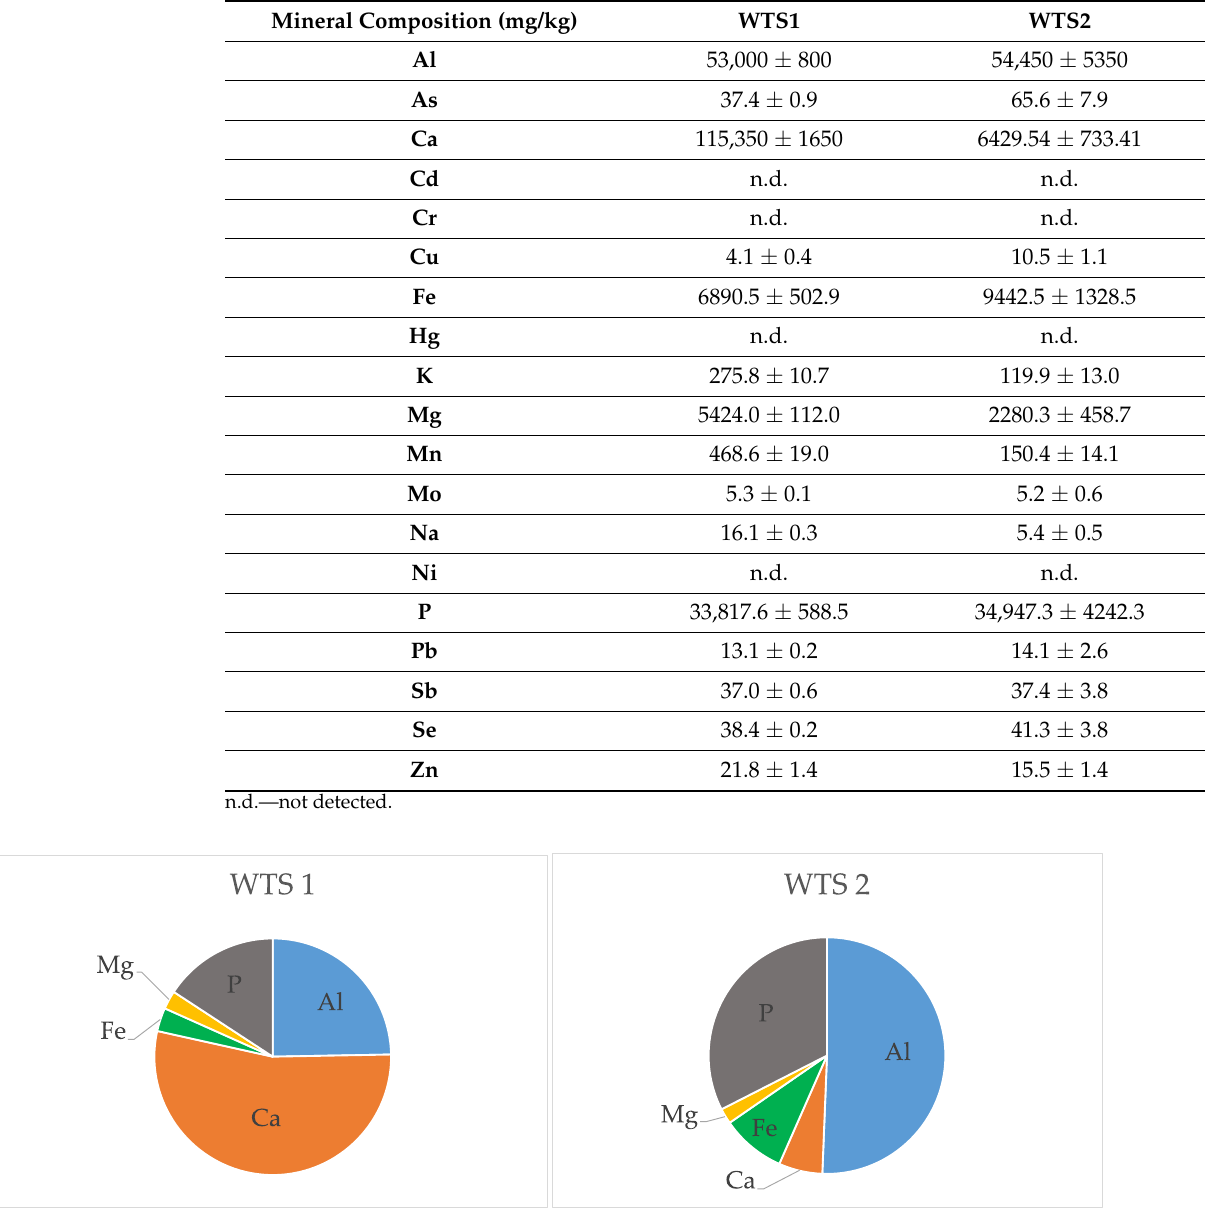
Figure 2. Thermogravimetric analysis (TGA) curves for the two water treatment sludges (WTSs) evaluated. During the TGA analysis, the total mass loss was 34% and 27% for WTS1 and WTS2, respectively. These values may suggest that, through a regeneration/activation process, a significant mass was lost [61]. Both samples presented weight loss associated with water loss at 105 °C: WTS2 humidity was 6.5%, while for WTS1, this was 2.5%. WTS1 also pre- sented a significant mass loss above 700 °C, which could be related to the decomposition